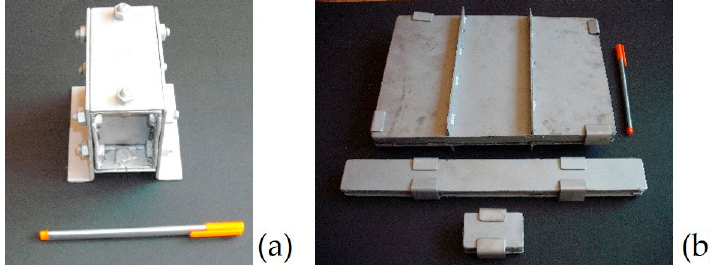
Figure 9. Real molds with screw system ( a ) and with clamping system ( b ).